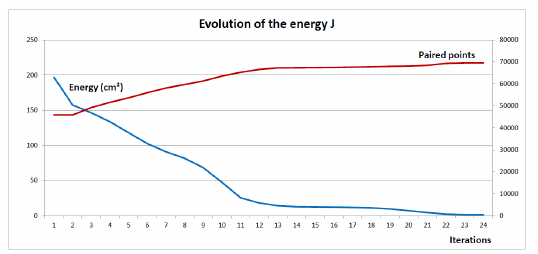
Figure 9: Evolution of the energy of synthetic point cloud #1